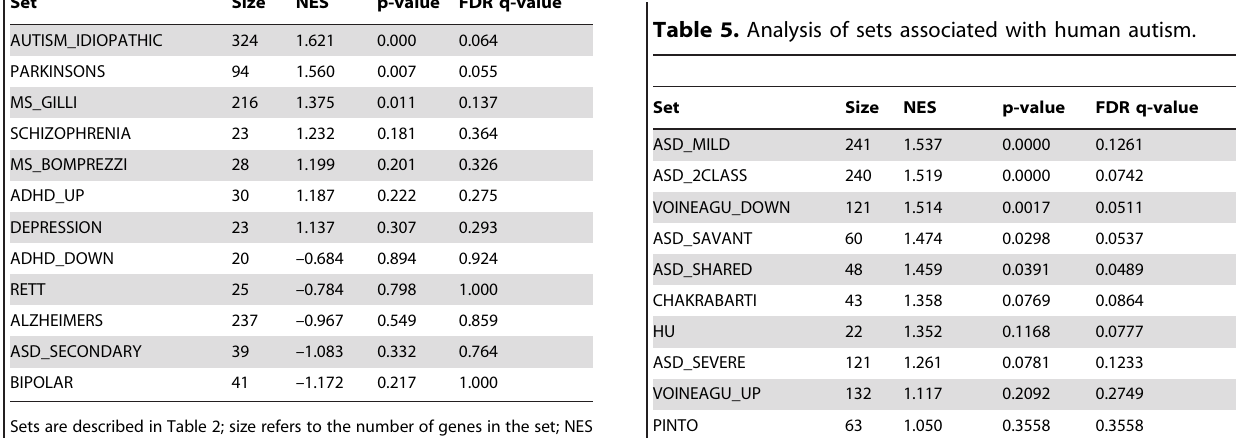
Column labeled as in Table 4. Sets are described in Table 3.